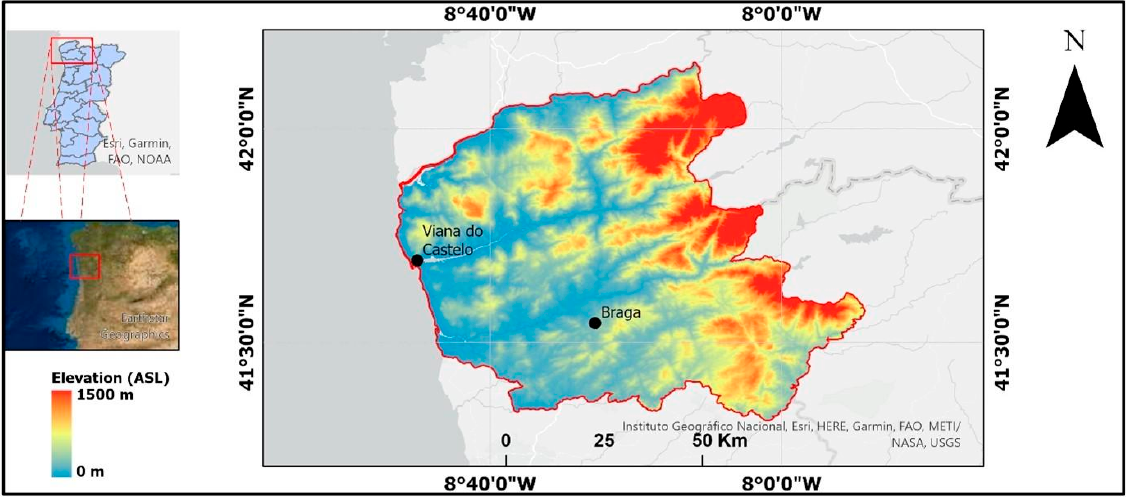
Figure 2. Location of the study area and the corresponding digital elevation model (DEM).